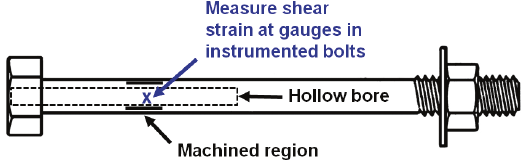
Fig. 13. Schematic of strain gauge placement, static shear test.